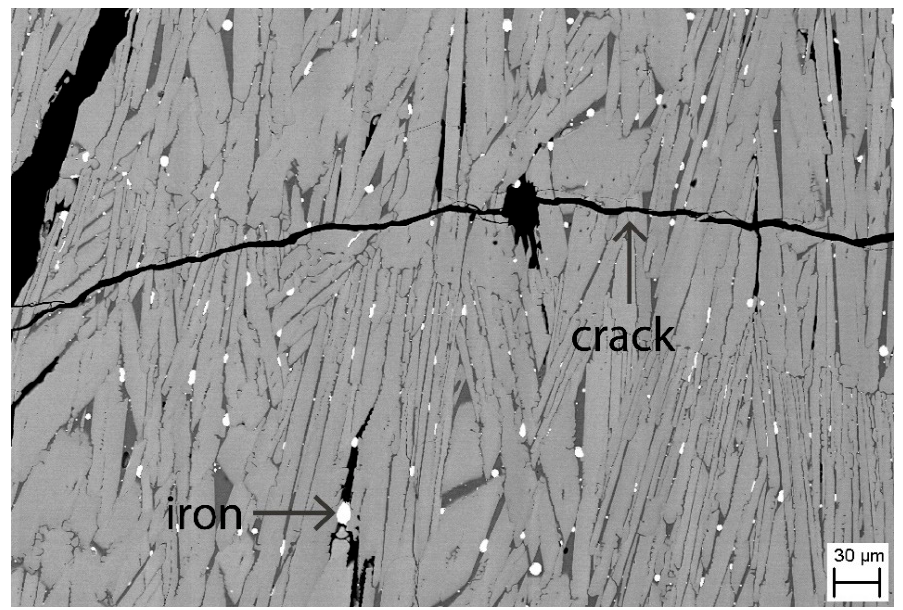
Figure 4. Microstructure of the dip-rod sample showing the elongated grains. The black lines are the cracks, and the white spots are metallic iron.